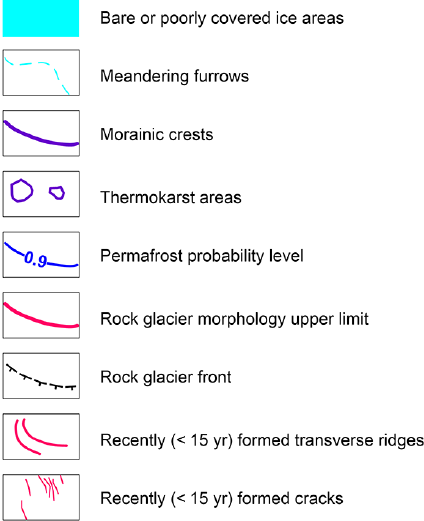
Figure 2. Geomorphological legend shared for all subsequent fig-